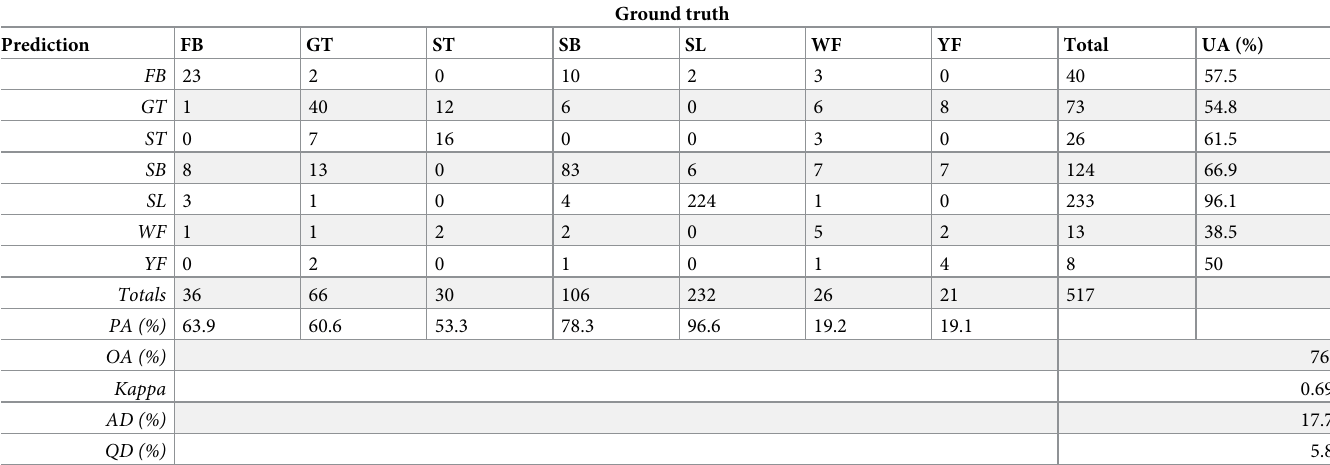
Table 7. Confusion matrix for the classification of flowering vegetation communities in the Mwingi study site obtained using random forest classifier and World- View-2 image for the end of the flowering season (April 2014) using the WorldView-2 image. Ground truth